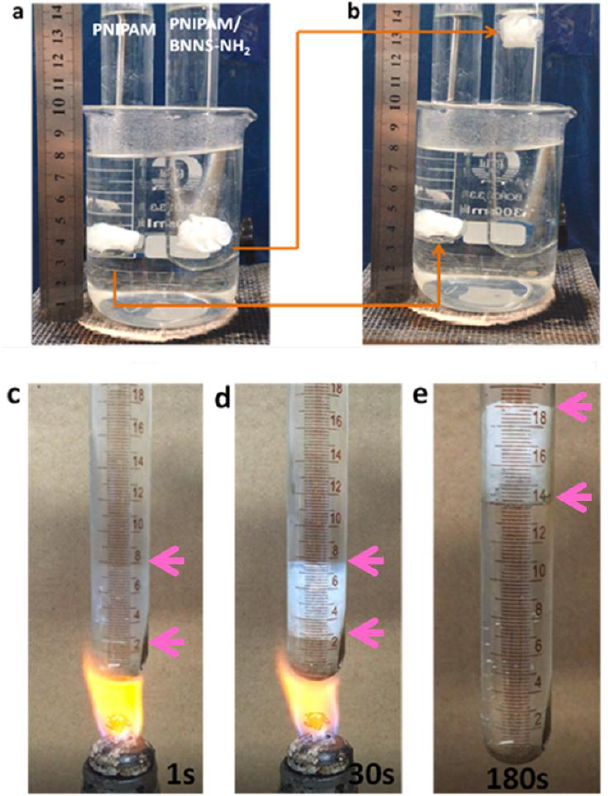
Figure 3. Digital photographs of hydrogels under heating: ( a ) at the beginning of heating, ( b ) heating for 10 min by a spirit lamp, PNIPAM/BNNS-NH 2 hydrogels were heated for ( c ) 1 s, ( d ) 30 s and ( e ) 180 s from room temperature.